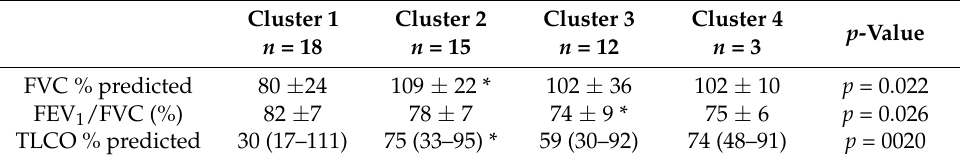
Table 2. Comparison of lung function parameters in cluster